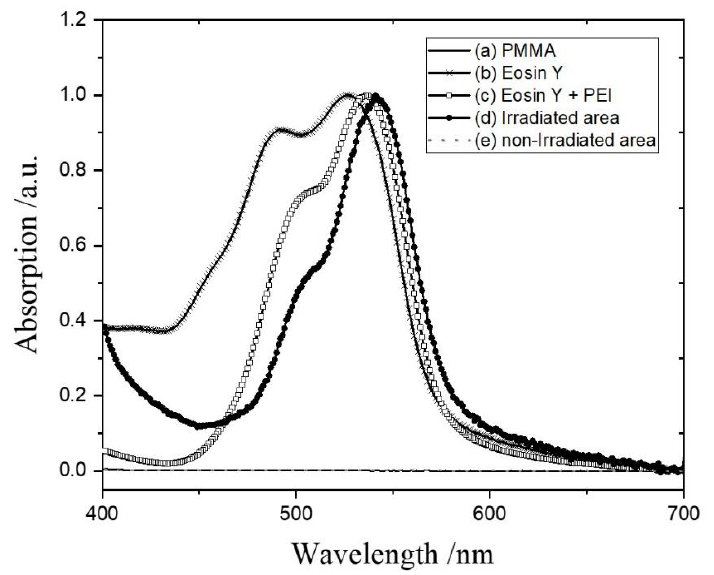
Figure 9. UV – Vis spectra of bare PMMA (a), Eosin Y cast on PMMA (b), Eosin Y reacted with PEI-cast PMMA (c), Eosin Y – PEI complex obtained by laser irradiation after extraction (d), and non-irradiated area (e) after extraction.